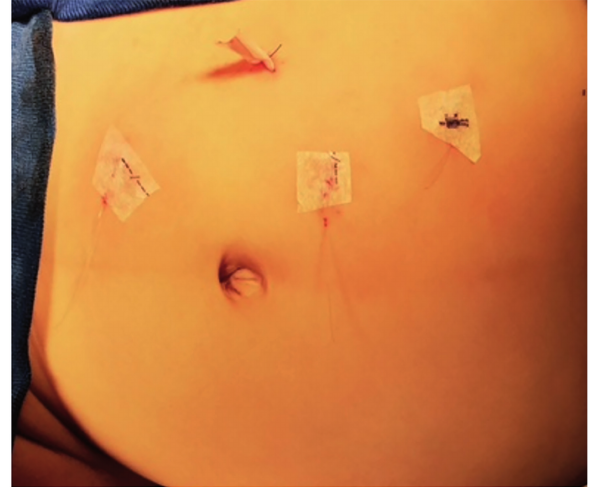
Position of the trocars - right pyeloplasty, one 5mm port to the telescope placed above and lateral to the umbilicus on the side of the affected kidney and three 3mm trocars to the